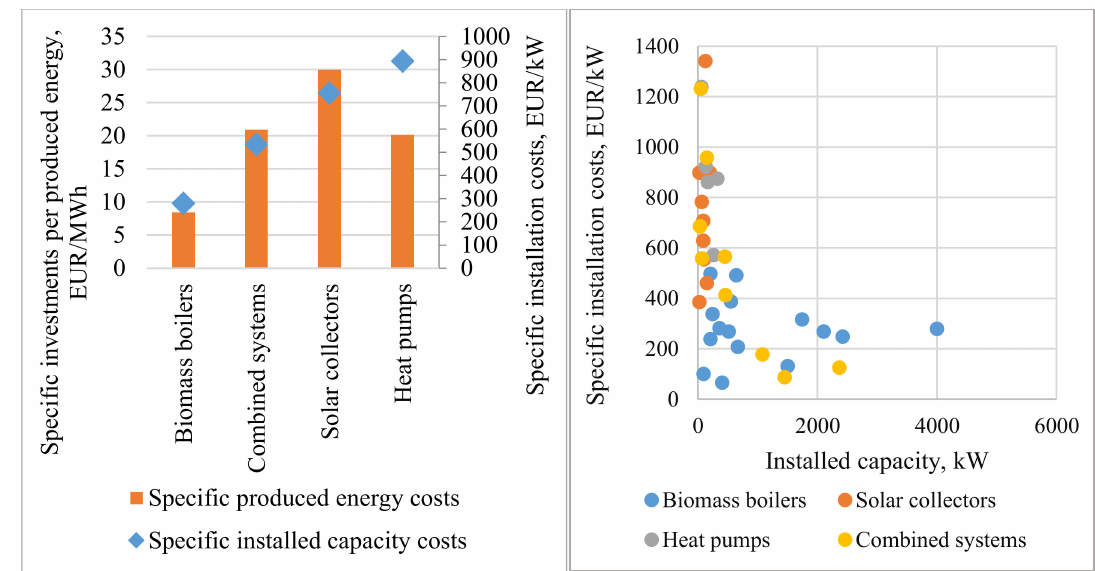
Figure 2. Cost E ff ectiveness Indicators for di ff erent RE technologies in Climate Change Financial Instrument (CCFI) co-financed